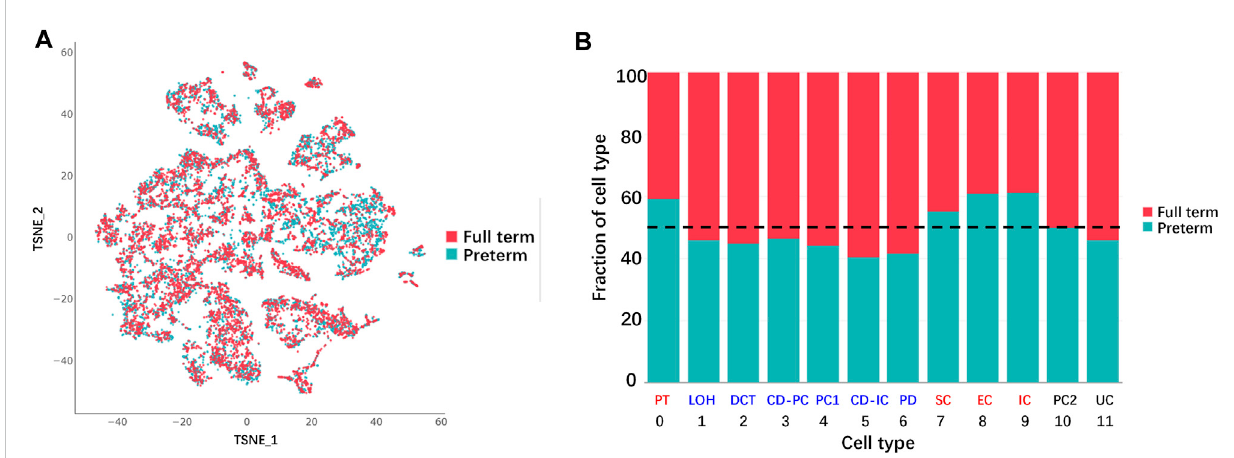
FIGURE 3 Differences in cell populations between full-term (postnatal day 0) and preterm kidneys (postnatal day 2). (A) Cells from full-term and preterm rat kidneysareshownintheTSNEgraph. (B) Fractionofcellsfromeachsampleforeachcluster.Allsampleswerenormalizedtothesamenumberofcellsand chi square tests were used for comparison. Reduced cell numbers for the LOH, DCT, CD-PC, PC1, CD-IC, and PD populations were examined in the kidneysofpretermrats(bluecolor).IncreasingcellnumbersofPT,SC,ECandICweredetectedinthekidneysofpretermrats(redcolor).Cellsinthe PC2 and UC populations were not different between full-term and preterm rat kidney (black color). (abbreviations: LOH, loop of Henle; DCT, distal